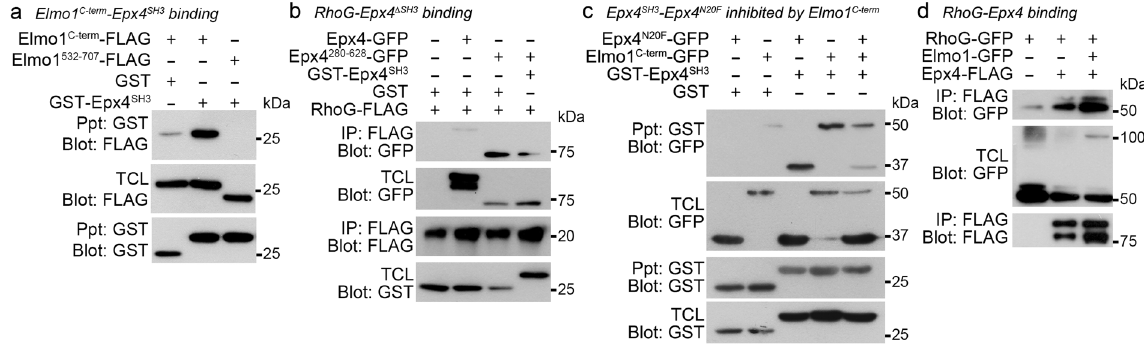
Figure 4. The association between the SH3 domain and the N20 region impeding RhoG access is disrupted by Elmo1. ( a ) 293 T cells were transfected with the indicated plasmids and lysed. The lysates were incubated with glutathione-sepharose beads. GST-tagged proteins were precipitated with the beads and then co-precipitated proteins were detected with anti-FLAG antibody. ( b ) 293 T cells were transfected with the indicated plasmids and lysed in lysis buffer containing 10 µ M EDTA. FLAG-tagged proteins were precipitated with anti-FLAG antibody, and RhoG binding was detected with anti-GFP antibody. ( c ) 293 T cells were transfected with the indicated plasmids, and proteins that co-precipitated with the SH3 domain of Ephexin4 were detected with anti- GFP antibody. ( d ) Nucleotide-free RhoG associated with Ephexin4 was evaluated in 293 T cells in the presence or absence of exogenous Elmo1 as in (b). Immunoblots are cropped for conciseness and their full-length blots are shown in Supplementary S6. Epx4, Ephexin4; TCL, total cell